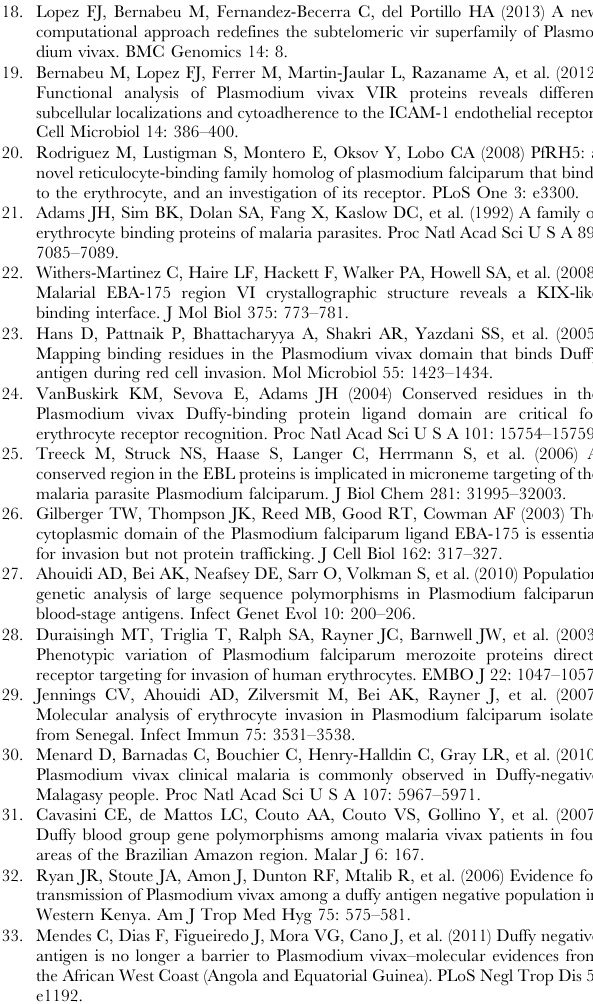
Table S1 Contigs generated from the C127 sample with their length, percentage of the contig sequence mapped to the reference genome (%Sal I), number of predicted genes and blast comparisons to the nucleotide (nt) and protein (nr) databases. Table S2 List of all contigs mapping partially to the Salvador I reference